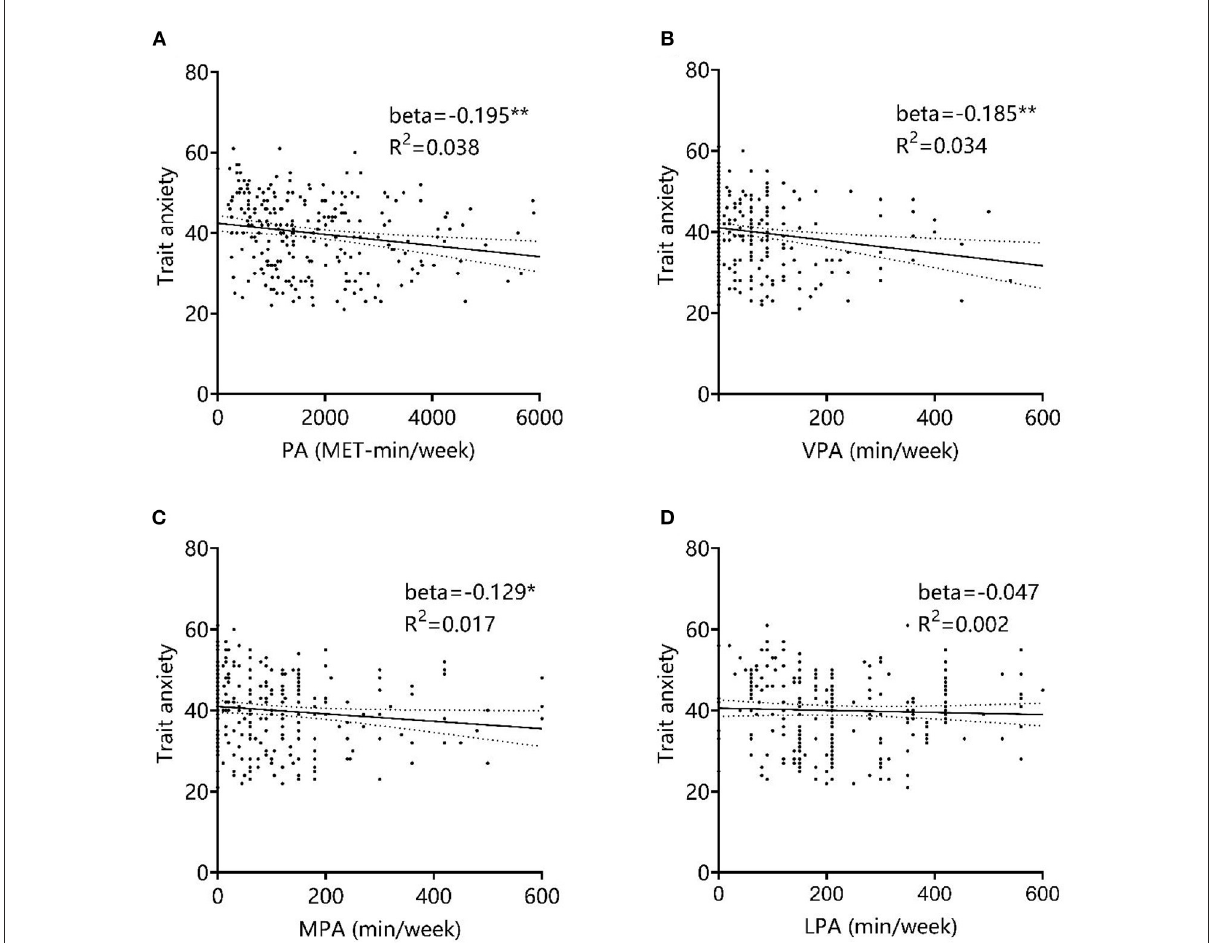
FIGURE5 Effect of physical activity levels on trait anxiety. (A) PA, (B) VPA, (C) MPA, and (D) LPA. P < 0.05, P < 0.01 and P < 0.001 were marked with “*,” “**” and “***,” all representing differences with statistical significance.